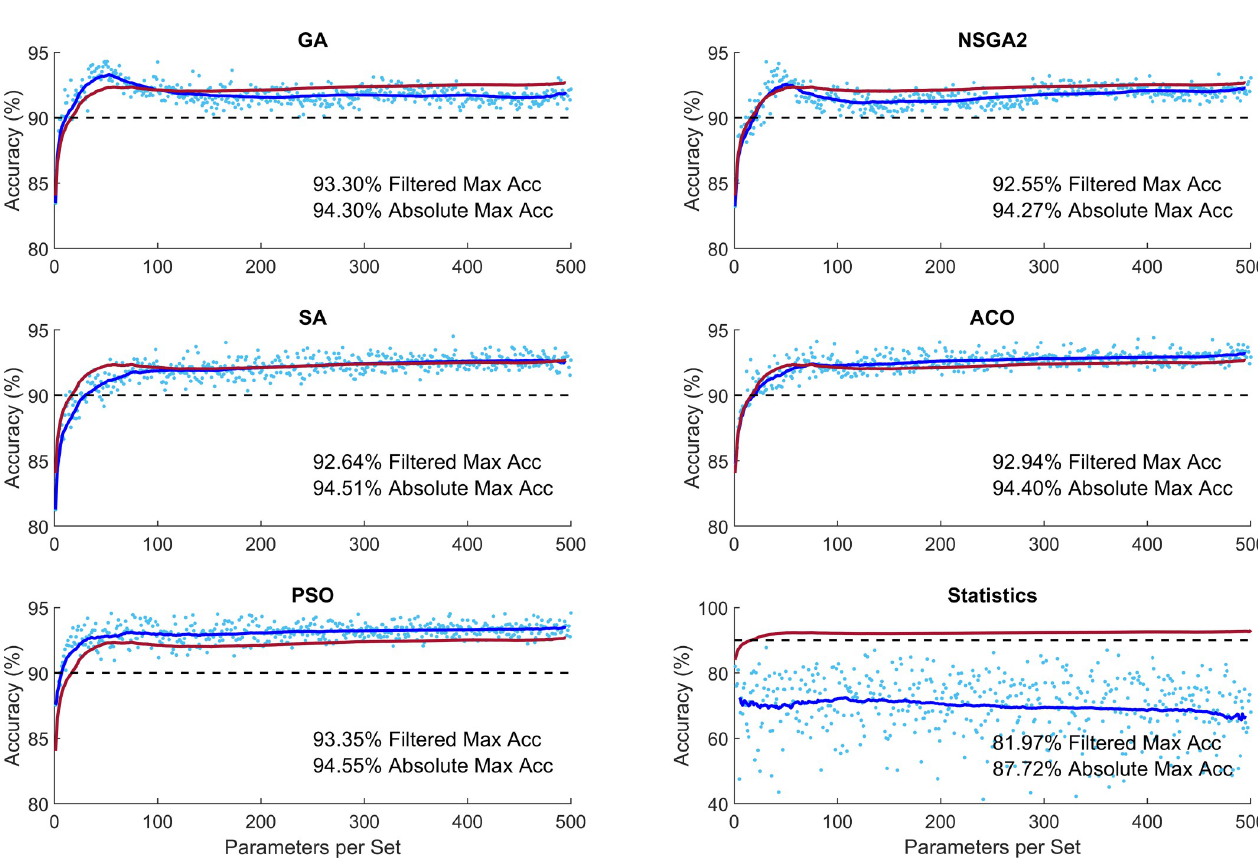
Fig 4. Performance of different optimization methods for increased number of parameters per subset. The light blue dots indicate the performance of algorithms for each subset of parameters. The dark blue curve shows the moving average of the samples with window of ± 20 points (Filtered Data). The red curve shows the mean performance of the five evolutionary algorithms. GA: Genetic algorithm; NSGA2: Nondominated sorting genetic algorithm II; ACO: Ant colony optimization; SA: Simulated annealing; PSO: Particle swarm optimization.